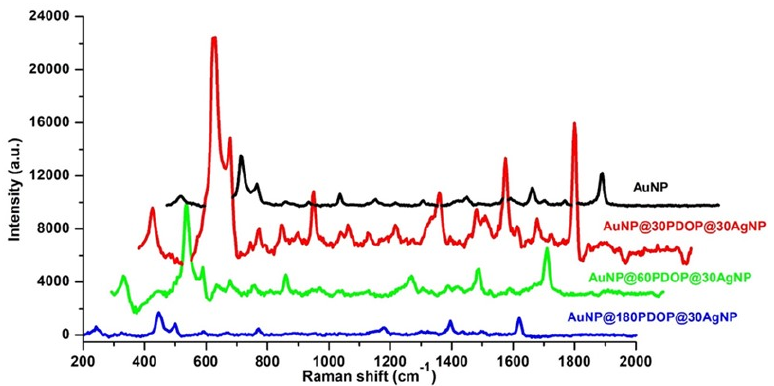
Figure 10. Effect of PDOP polymerization time (i.e., PDOP thickness) on SERS effect for 30 min of silver reduction time. Representative Raman measurements of the bimetallic core–shell NP system for different PDOP deposition times (numbers indicate deposition times in min). The final concentration of MB for Raman measurement is 10 −5 M.